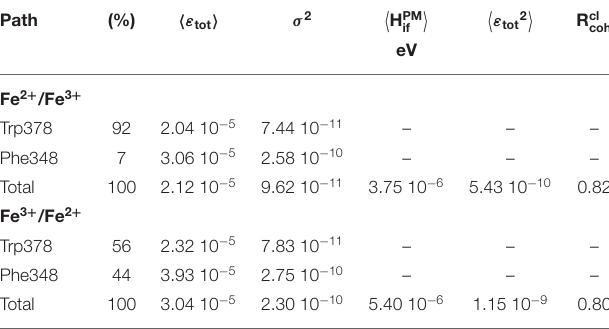
TABLE 1 | Semi-empirical pathway analyses of tunneling matrix elements mediating inter-heme electron